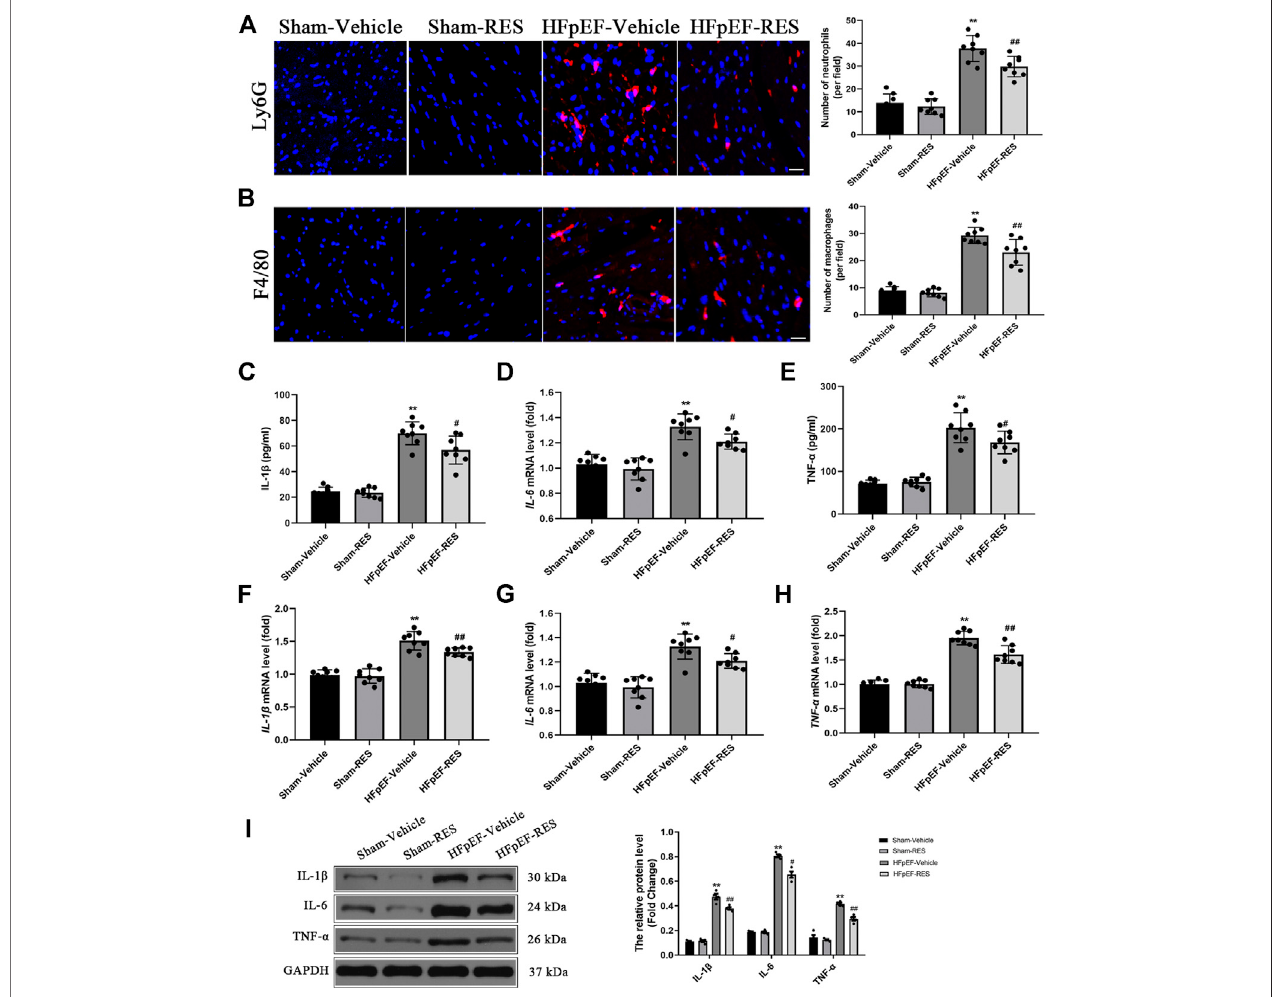
FIGURE 3 | Effect of RES on HFpEF-induced in fl ammation. (A) Representative Ly6G and (B) F4/80 immuno fl uorescence staining. (C – E) Concentration of plasma pro-in fl ammatory cytokines IL-1 β , IL-6, and TNF- α ( n (cid:2) 8 per group). (F – H) Results of IL-1 β , IL-6, and TNF- α mRNA expressions ( n (cid:2) 8 per group). (I) Representative western blots and quantitative results of the IL-1 β , IL-6, and TNF- α proteins ( n (cid:2) 8 per group). ** p < 0.01 vs. sham-vehicle group. # p < 0.05 vs. HFpEF-vehicle group. ## p < 0.01 vs. HFpEF-vehicle group. Scale bars, 50 µm.